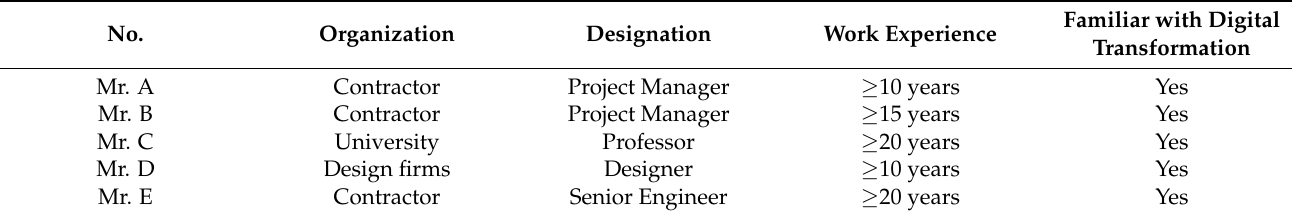
Table 3. The profiles of five experts.